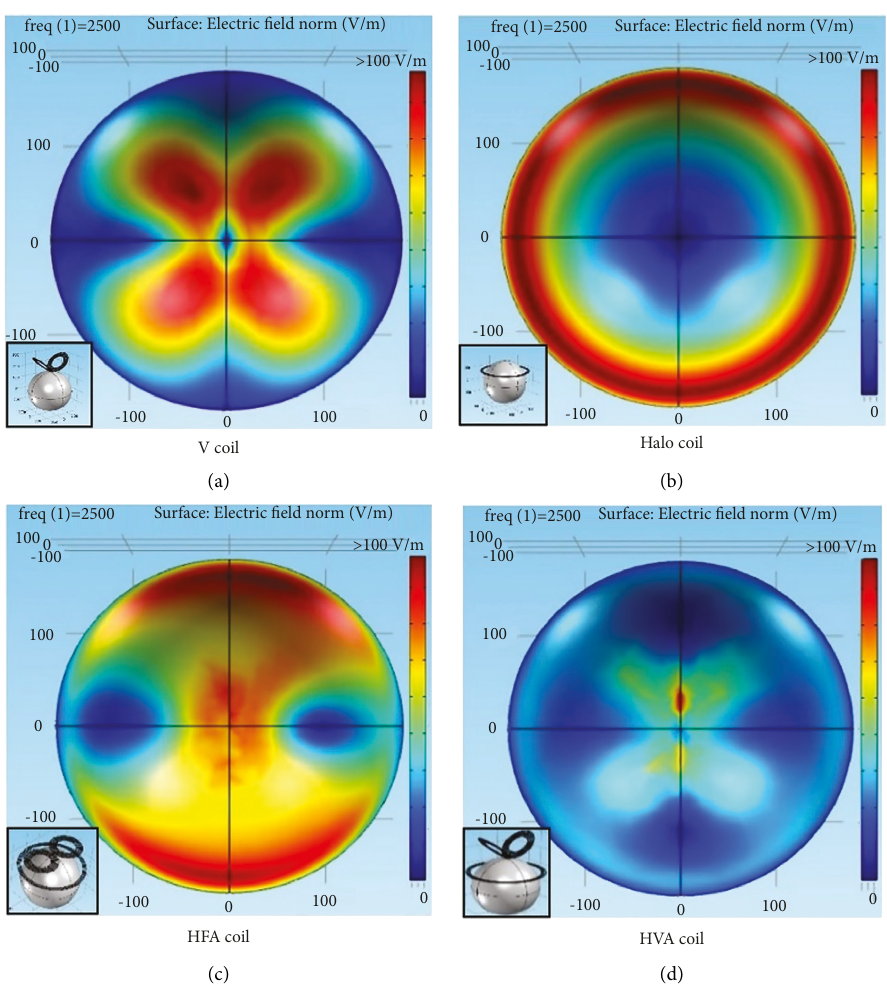
Figure 11: Comparison of the surface electric field distribution of different coils.